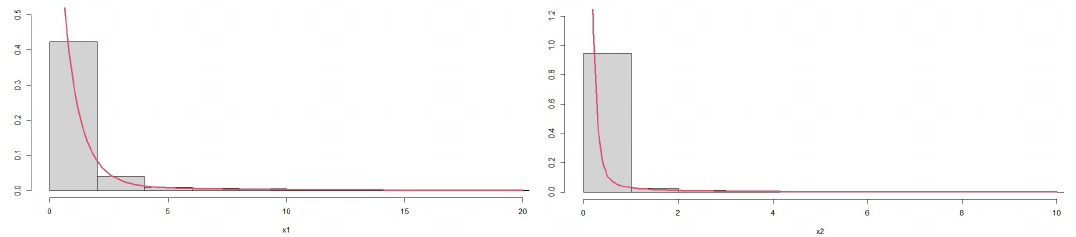
Figure 7. Histogram of real data marginals with fitted pdfs: left , X 1 ; right , X 2